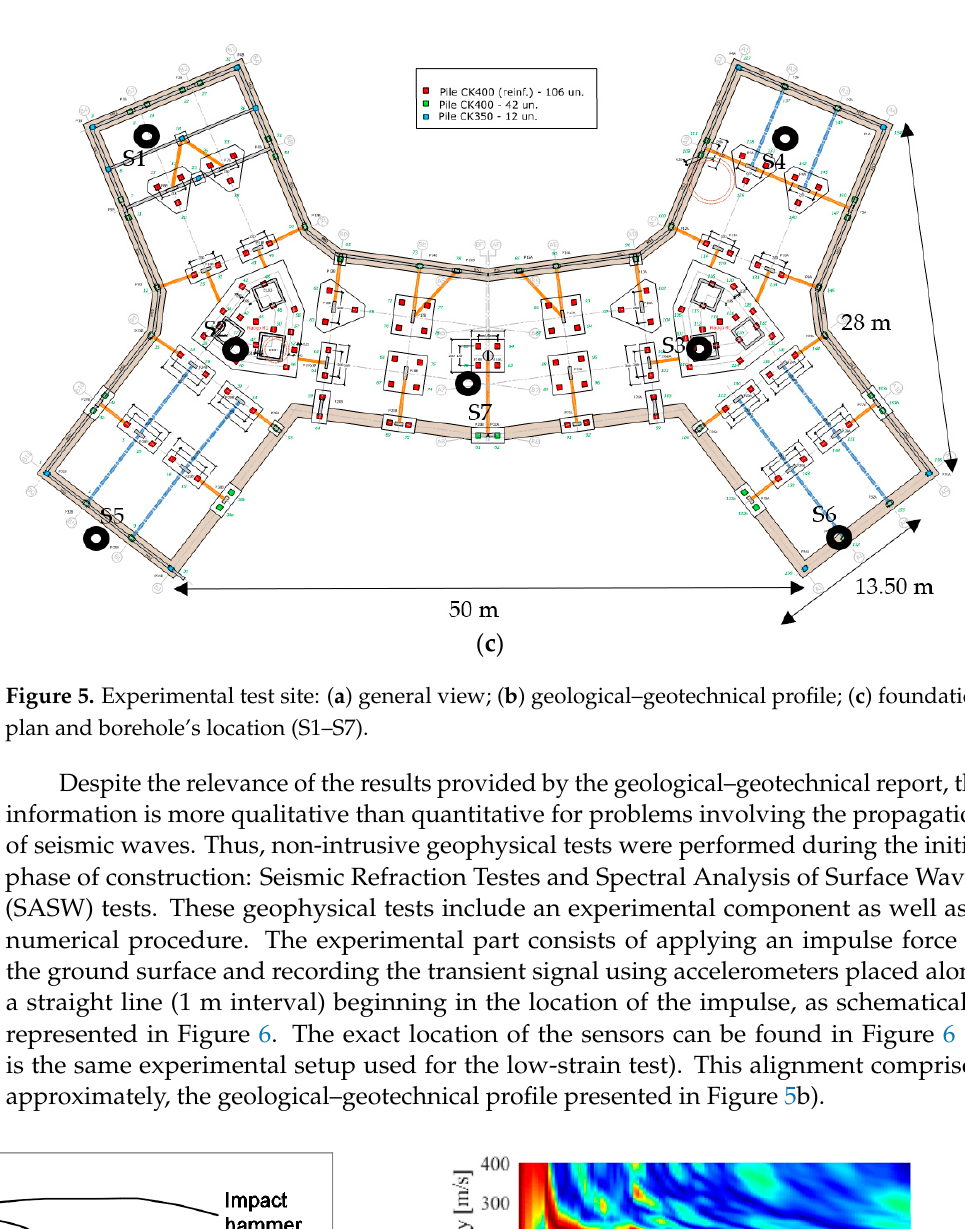
Figure 5. Experimental test site: ( a ) general view; ( b ) geological–geotechnical profile; ( c ) foundation plan and borehole’s location (S1–S7).